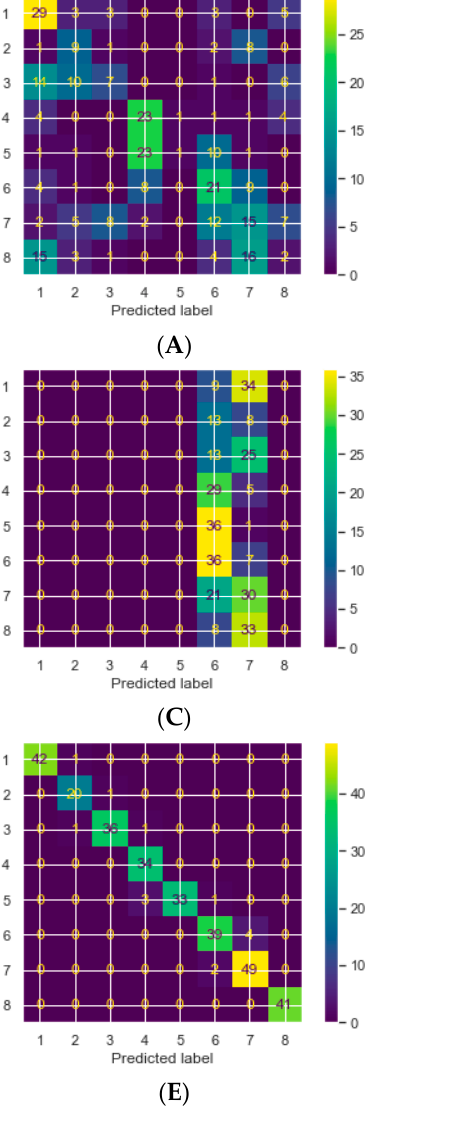
Figure 13. Confusion matrix of the model’s comparison chart. ( A ) Confusion matrix of logistic regression. ( B ) Confusion matrix of naive bayes. ( C ) Confusion matrix of SVM. ( D ) Confusion matrix of KNN. ( E ) Confusion matrix of DT.